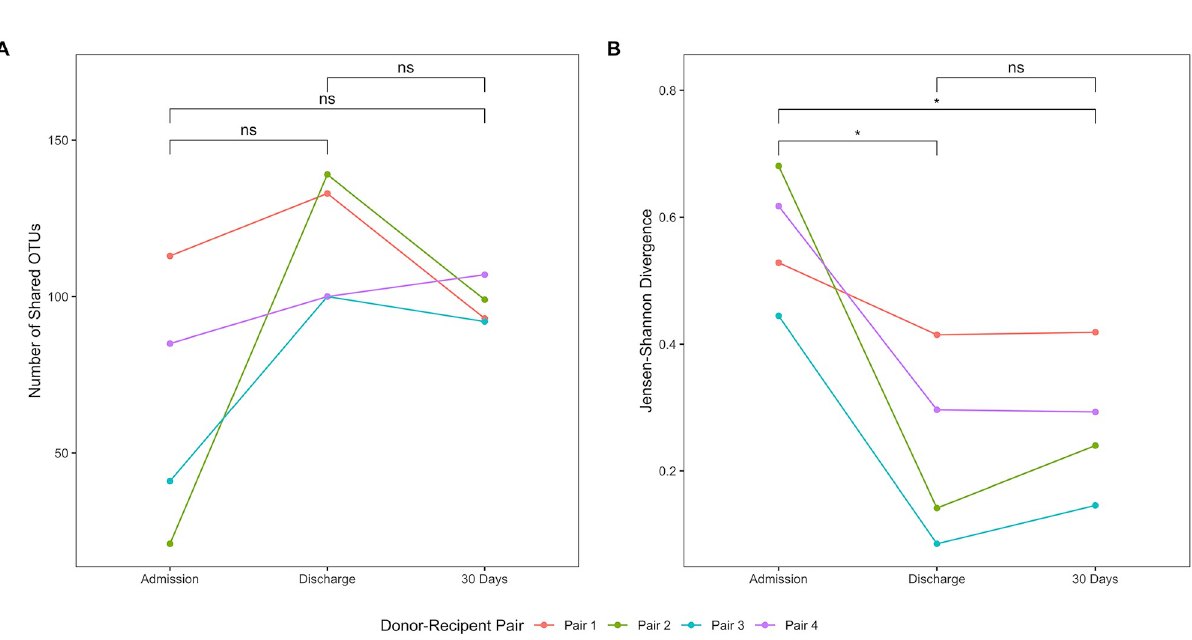
Fig 5. Analysis of relationships among donor-recipient pairs. The number of shared OTUs and Jensen-Shannon divergence were used to characterize associations between donor-recipient pairs. Results were compared using a repeated measures ANOVA. (A) The number of OTUs shared among donor-recipient pairs increased following fecal microbial transplantation, but the results were not significant. (B) Divergence among donor- recipient pairs decreased significantly from admission to discharge, and from admission to 30 days. Statistical comparisons among treatment groups and collection times are indicated by annotated brackets where “ns” represents P � 0.05 and “ � ” represents 0.01 < P < 0.05.